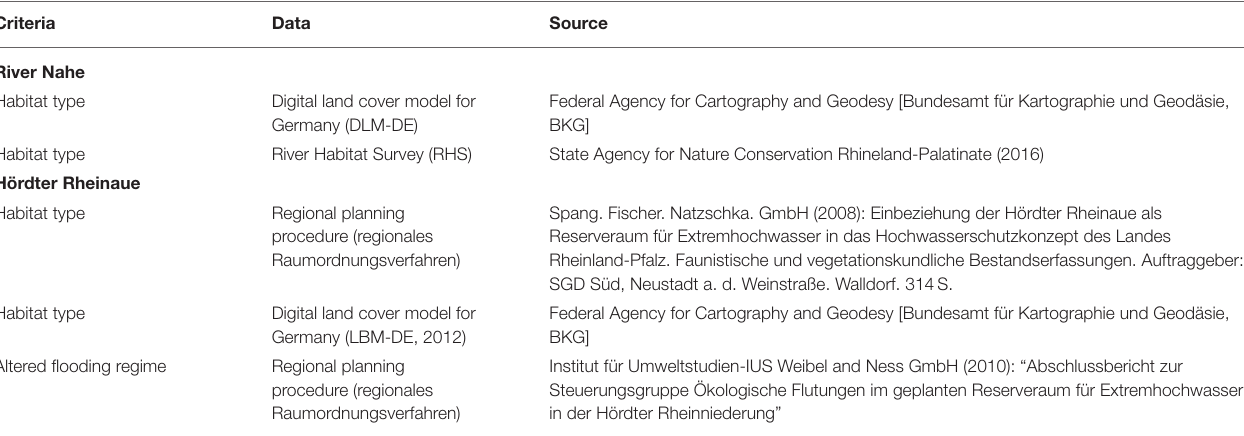
TABLE 7 | Overview of applied spatial data for the habitat provision index and their sources for the River Nahe and Hördther Rheinaue (River Rhine). Criteria